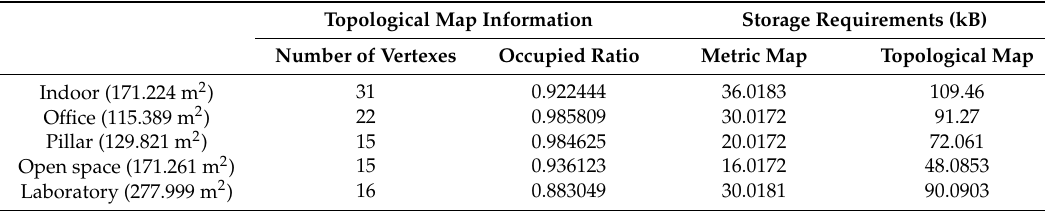
Table 1. Topological map information for each Table 3. Topological map information for each scene.